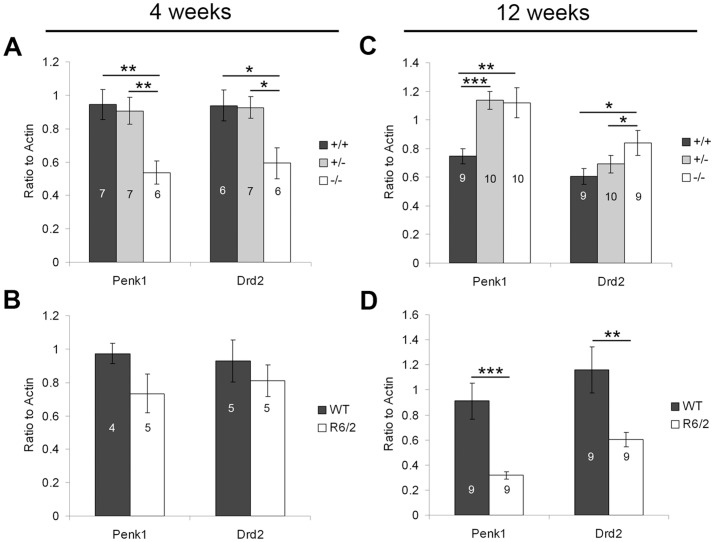
Transcriptional profile of indirect pathway markers.Gene expression of preproenkephalin (Penk1) and dopamine receptor 2 (Drd2) was measured in striatum of PGC-1α and R6/2 HD mice and littermate controls at four and twelve weeks using q-RT-PCR. A. At four weeks of age, expression of Penk1 and Drd2 was significantly decreased in PGC-1α −/− compared to +/+ and +/− mice. B. No changes were observed in R6/2 HD mice at this age. C. By twelve weeks of age, Penk1 was significantly increased in PGC-1α −/− and +/− compared to +/+ mice, and Drd2 was significantly increased in PGC-1α −/− compared to +/+ and +/− mice. D. Both Penk1 and Drd2 were significantly decreased in R6/2 HD mice at this age. For A and C, one-way ANOVA followed by Fisher's LSD. For B and D, two-tailed t-tests. *p<0.05. **p<0.005. ***p<0.0005. n/group indicated on histograms. Data presented as mean ± SEM.